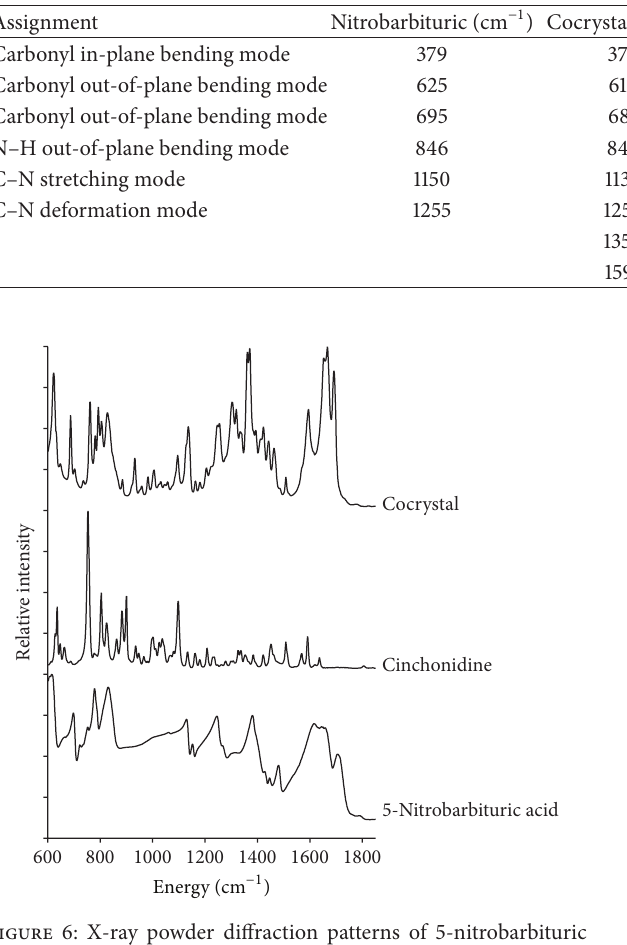
Figure 7: Infrared absorption spectra within the fingerprint region of 5-nitrobarbituric acid, cinchonidine, and the 1: 1 nitrobarbituric- cinchonidine